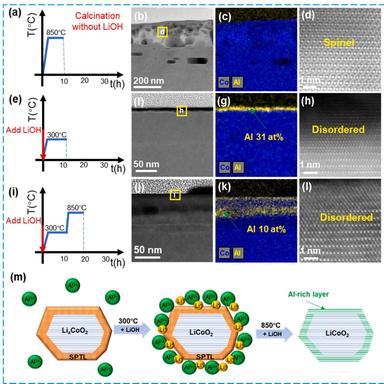
Formation mechanism of the Al-enriched surface layer.(a) The sintering protocol without lithium replenishment.(b, c) STEM-HAADF image and its EDS mapping, revealing the sample with massive voids and free of Al impurities on the particle surface.(d) Lattice image from the surface region "d" in (b) showing the spinel structure.(e) The sintering protocol with lithium replenishment.(f, g) STEM-HAADF image and its EDS mapping, demonstrating Al impurity segregated at the particle surface.(h) Lattice image of the